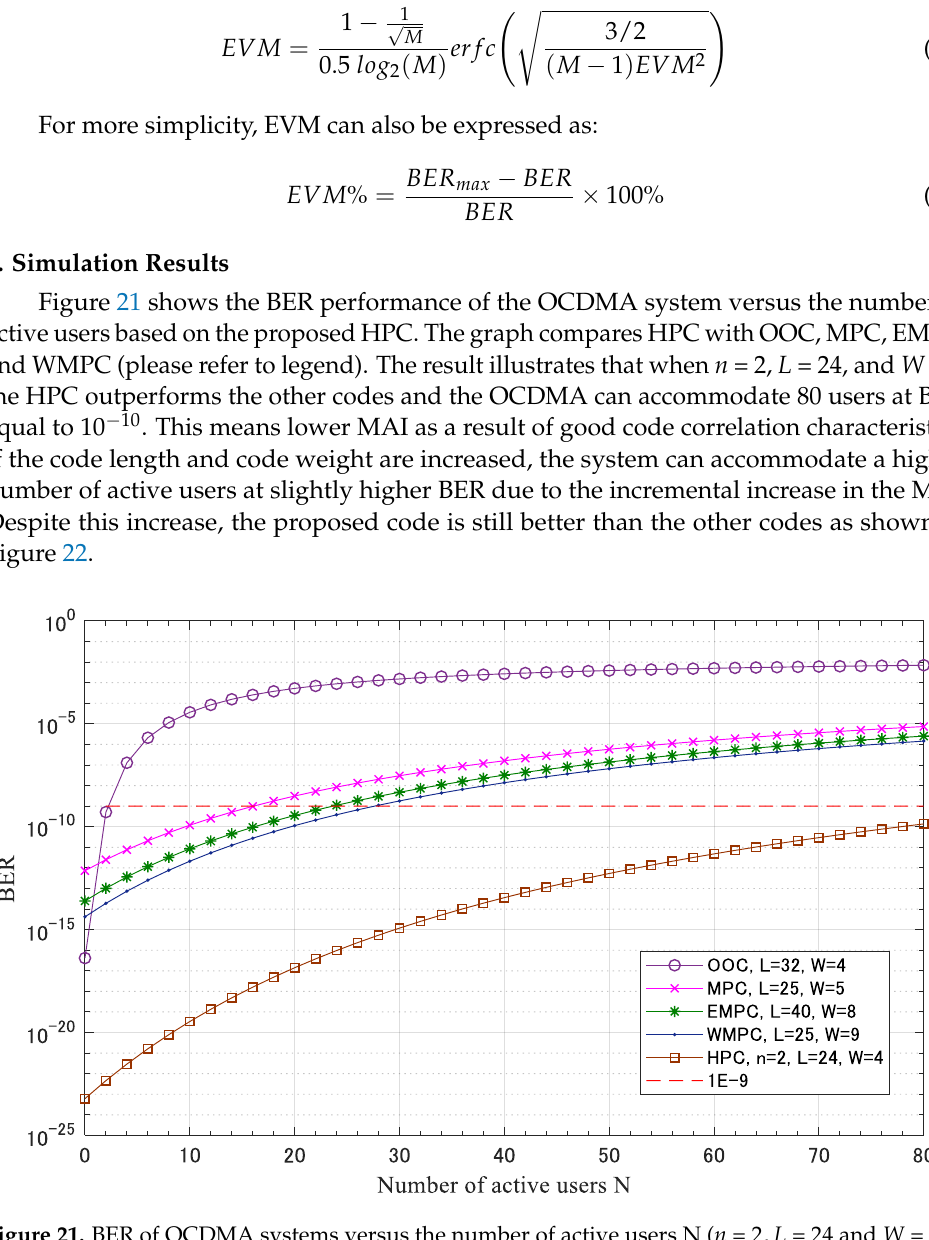
Figure 22. BER of OCDMA systems versus the number of active users N ( n = 3, L = 36 and W = 6).